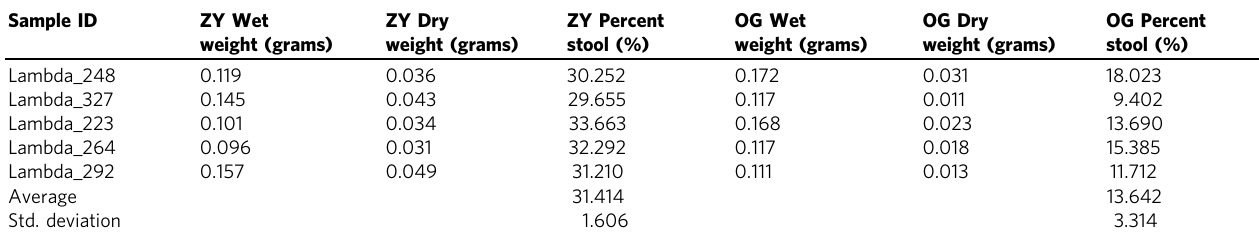
Table 1 Measurement of wet weight and dry weight from fi ve paired stool samples collected from COVID-19 patients in OG and